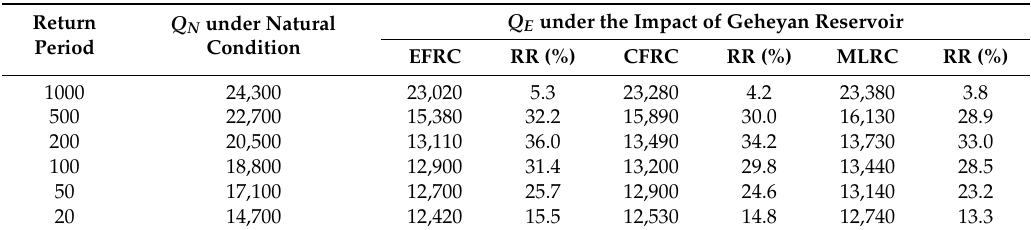
Table 5. Peak discharges at Gaobazhou reservoir site with different return periods under the impact of Geheyan reservoir operation (m 3